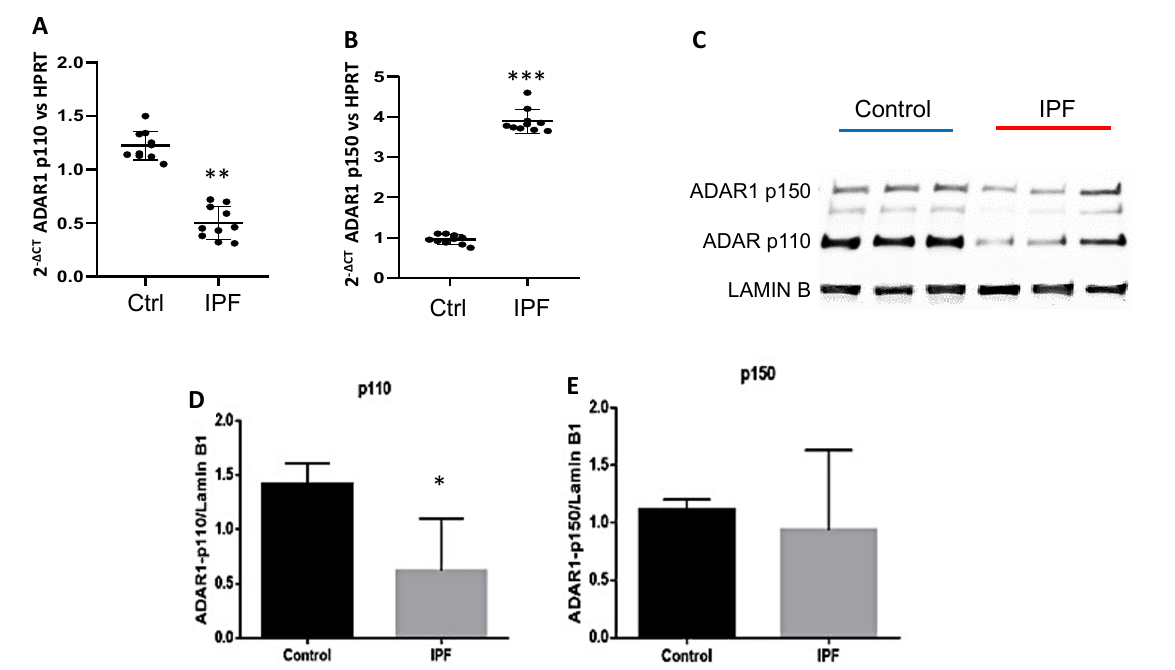
Figure 1. Expression levels of ADAR1-p110 and ADAR1-p150 in control compared with fibrotic fibroblasts. ( A ) ADAR1-p110 is significantly down-regulated in IPF fibroblasts (** p < 0.0001). ( B ) ADAR1-p150 is significantly overexpressed in IPF fibroblasts (*** p < 0.0001). ( C ) Analysis of the protein levels of the isoforms of ADAR1 in total protein extracts corroborated the decrease in ADAR1-p110 (* p < 0.05), whereas ADAR1-p150 did not show significant differences. ( D ) Densito- metric analysis of the protein levels of ADAR1 ( C ) corroborates the decrease in ADAR1-p110 in fibrotic cells and no difference in ADAR1-p150 (E).